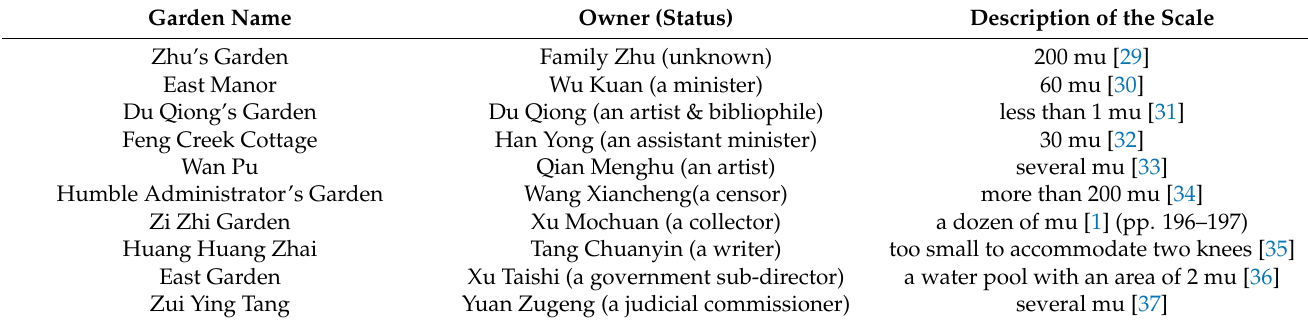
Table 3. Recorded scales of Suzhou private gardens in the Ming